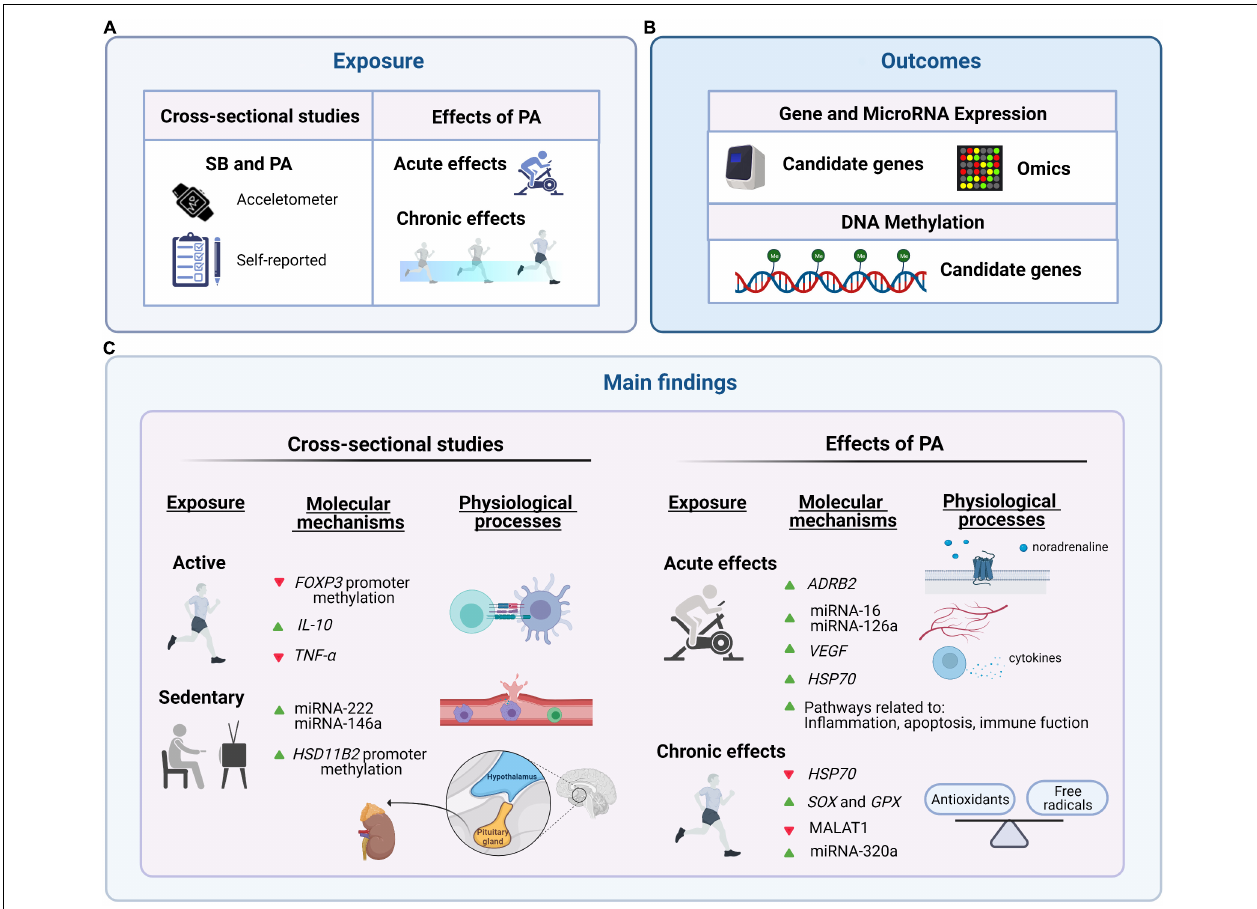
FIGURE 2 | Summary of the main candidate genes and gene pathways related to sedentary behavior (SB) and physical activity (PA) (i.e., acute and chronic effects) in the pediatric population. (A) Exposure: SB and PA (acute and chronic effects). (B) Outcomes: gene expression and epigenetics (candidate genes and high-throughput transcriptomics analyses). (C) Main findings: relevant genes identified in our systematic review. Green arrows reflect up-regulation and red arrows down-regulation. This figure was created with